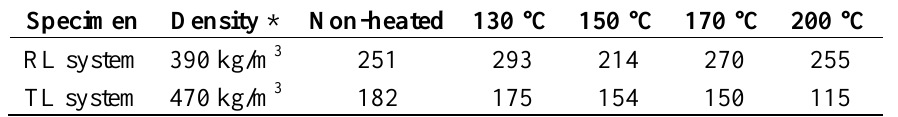
Table 1. Fracture energy (in J/m 2 ) of heated specimen in a single-end notched bending text.